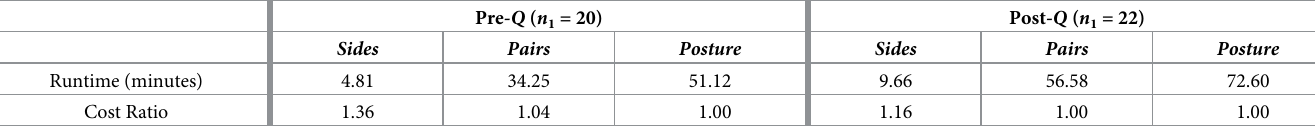
Table 3. Hypergraphical models more aptly contextualized posture than a graphical model but required more computation. Runtime (minutes) refers to the median runtime of each model in minutes. Cost ratio reports the median cost ratio, defined as the ratio of the correct posture cost to the returned posture cost. Hypergraphical models more effectively described posture than the graphical model at expense of computation.